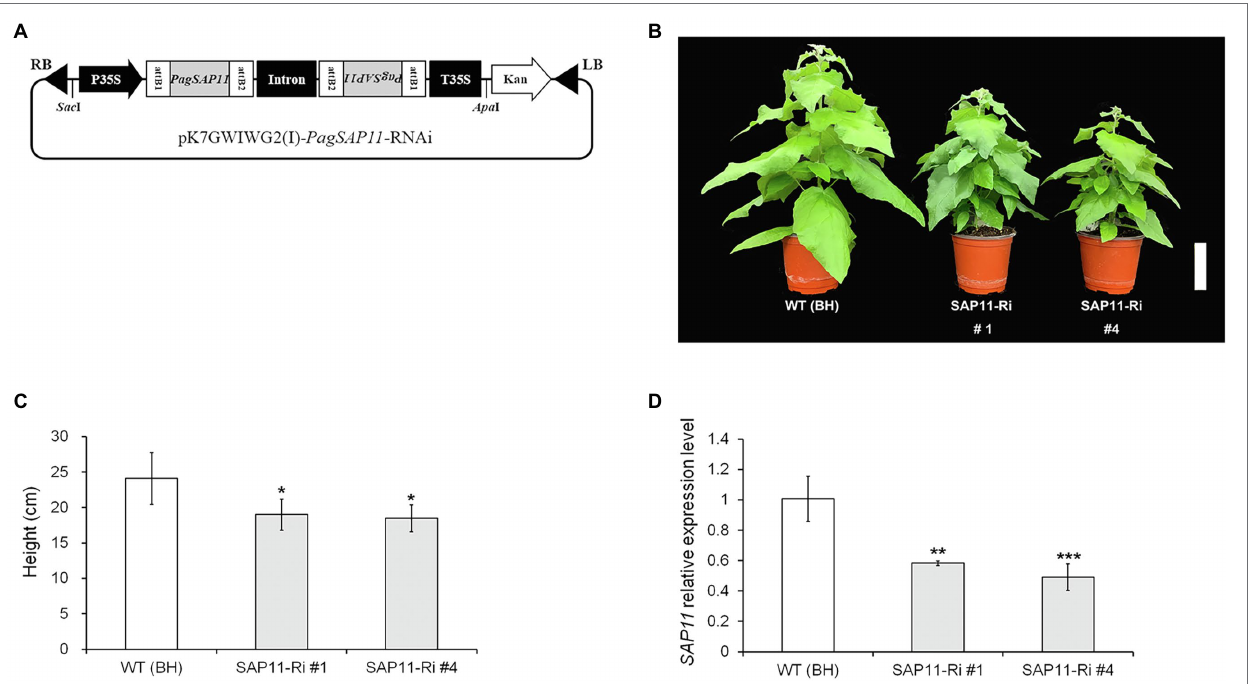
FIGURE 3 | Generation of PagSAP11 -RNAi transgenic poplar using Agrobacterium -mediated transformation. (A) Strategy for construction of expression vector pK7GWIWG2(I), containing the PagSAP11- RNAi. (B) Representative image of WT (clone BH) and independent two transgenic (SAP11-Ri #1 and #4) poplar plants grown for 2 months on soil after acclimation ( n = 15). (C) Measurement of plant heights from (B) . (D) Relative PagSAP11 transcript levels in each transgenic line. The expression levels of transgenic plants were confirmed using real-time qPCR. The values represent the means ± standard deviations (SDs) of three biological replicates. Asterisks indicate significant differences by student t- test (* p < 0.05, ** p < 0.005, *** p < 0.001). Scale bar = 10